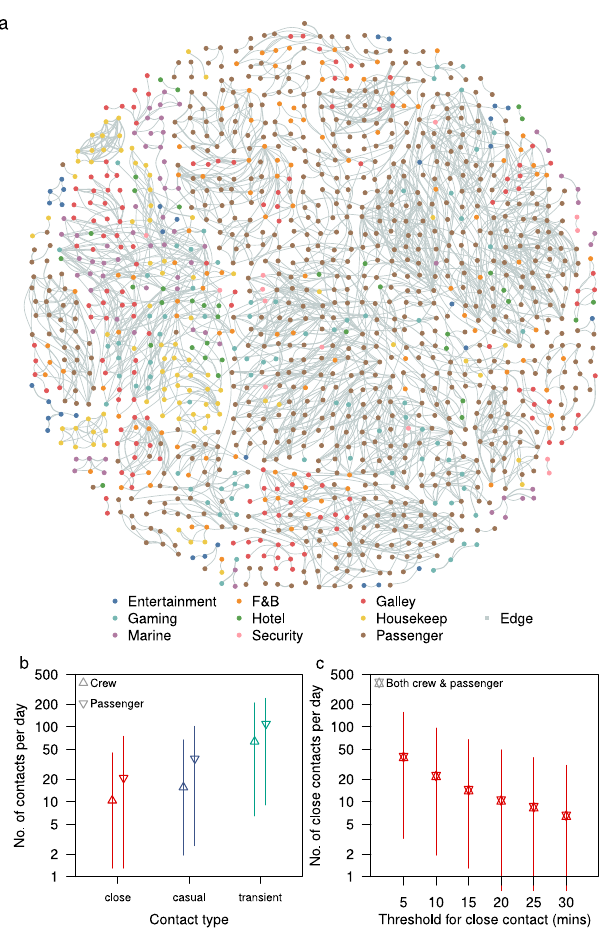
Fig. 1 Distribution of cruise ship contacts. a Illustrative short-term network dynamics, showing the cumulative network of all contacts that began between 12.00 to 12.05 pm on the second day of a sail and lasted till the end of their contact episode. Edge width and colour intensity are a function of the type of contact (i.e. close, casual and transient). Intra- and inter- cohort contacts are represented by the connection of nodes with the same and different colour respectively. b Number of unique close, casual, transient contacts made per day by passenger and crew. c Number of close contacts per day for both crew and passengers using different thresholds for the cumulative duration of interaction. Median (shapes), 50% (dark lines), and 95% intervals (light lines) of contacts from 5216 passengers and 4197 crew across four sailings are shown in ( b ) and ( c ).